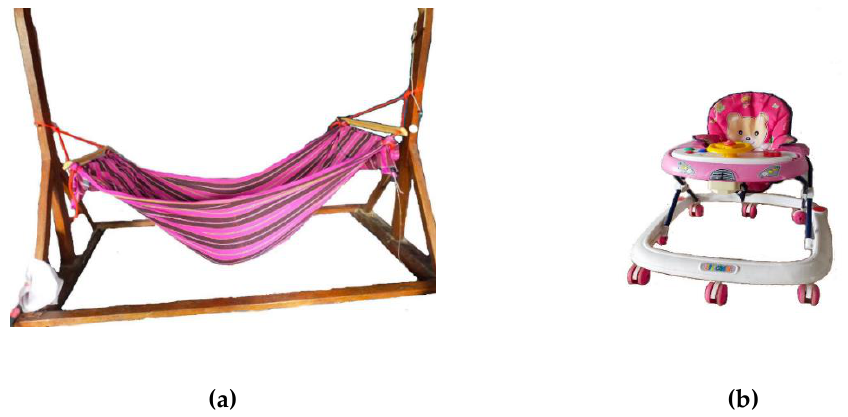
Figure 2. Childcare equipment: ( a ) Baby hammock; and ( b ) baby walker. Table 3 presents the regression results for the factors included in the model. The univariate analysis using the GLMM showed the relationship between the gross motor percentile and the analyzed factors; maternal and paternal education, household income, breastfeeding, equipment usage, sleep position during the day, and sleep position at night. Three factors remained in the final analysis: The use of a baby hammock, the use of a baby walker, and sleep position during the day (Table 4). The gross motor percentile was significantly positively associated with the use of a baby hammock (Coef. = 7.33; p = 0.04), whereas baby walker usage was negatively associated with the gross motor percentile (Coef. = − 8.83, p < 0.0001). Table 3. Factors affecting gross motor percentile (univariate analysis). Factors Coef. Std. Err